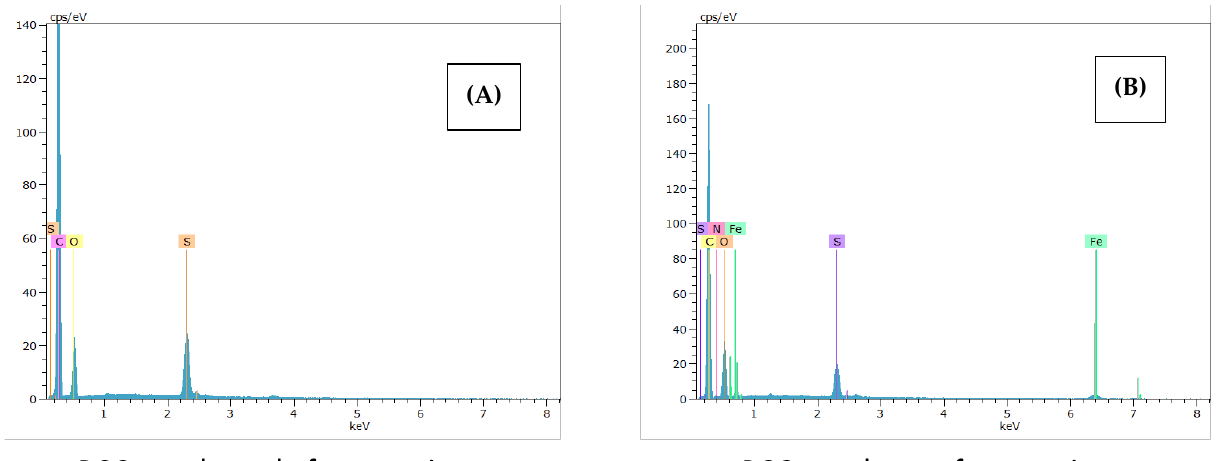
Figure 3. SEM-EDX spectra corresponding to the membrane modified with reduced graphene oxide ( A ) before and ( B ) after the experiments.